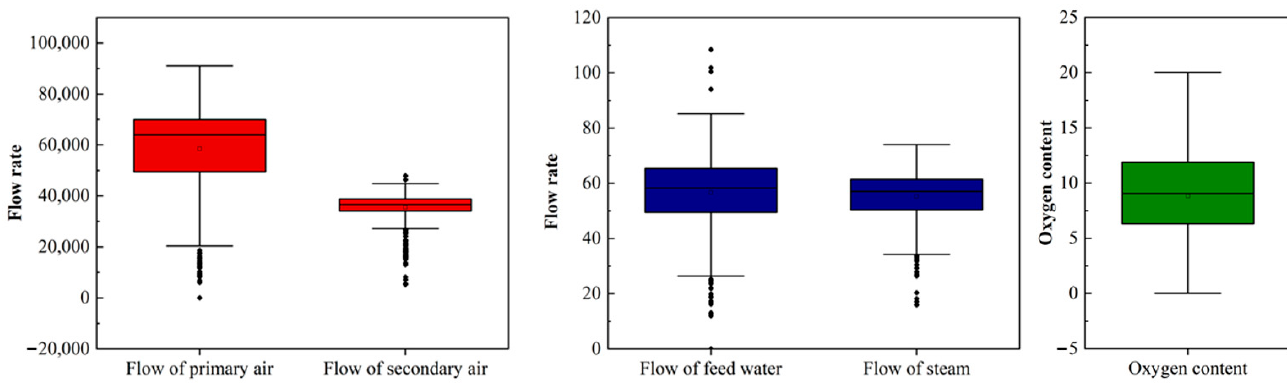
Figure 9. Comparison of the statistics for oxygen content, the flow of primary air and secondary air, feed water, and steam.